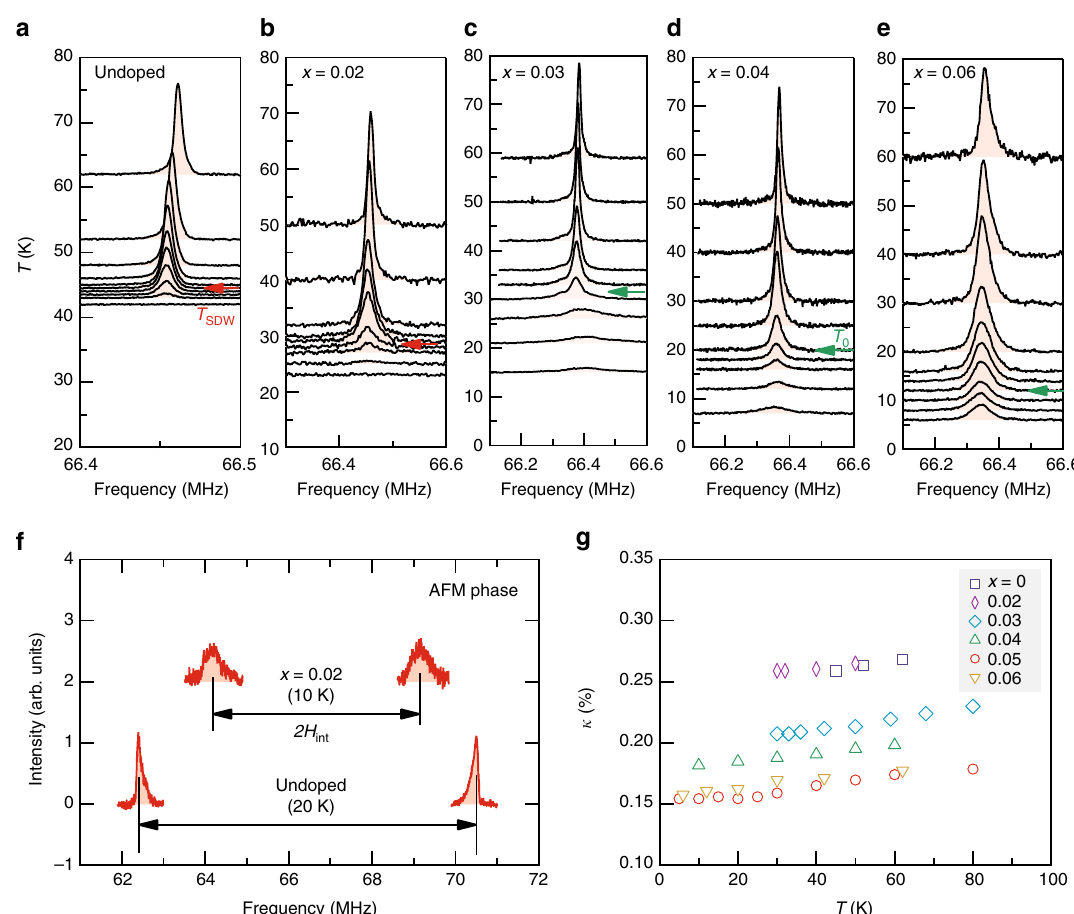
Fig. 3 75 As NMR spectra in Na 1 − x Li x FeAs for H || c . a – e Temperature dependence of the central line as a function of Li doping x measured at 9.1 T . For x = 0 and 0.02, the 75 As line rapidly disappears below T SDW due to the large hyper fi ne fi eld resulting from the static Fe spin moment arranged antiferromagentically. For x ≥ 0.03, the 75 As intensity remains fi nite down to low temperatures without a signi fi cant broadening, indicating the absence of long range magnetic order. f The AFM split 75 As lines were detected at low temperatures for x = 0 and 0.02, manifesting the commensurate AFM phase. g The Knight shift K as a function of temperature and doping at 9.1 T parallel to c . The almost constant K for a given x is rapidly reduced for x ≥ 0.03, suggesting a change of the Fermi surface